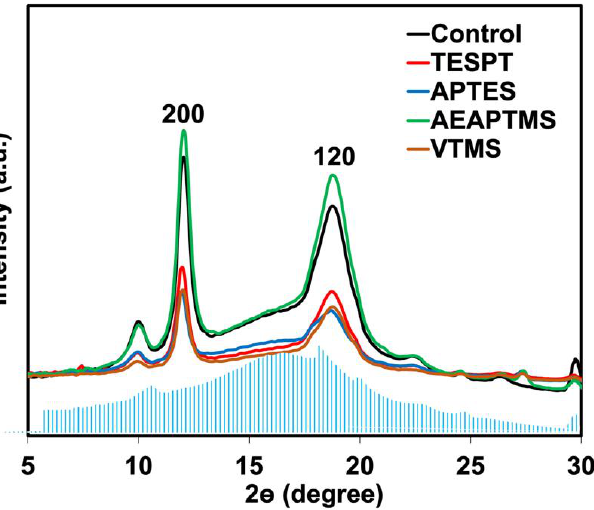
Figure 11. 1D WAXS patterns of unstretched (blue highlight) and 400% stretched NR/HNT compos- ites filled with and without silane coupling agents.